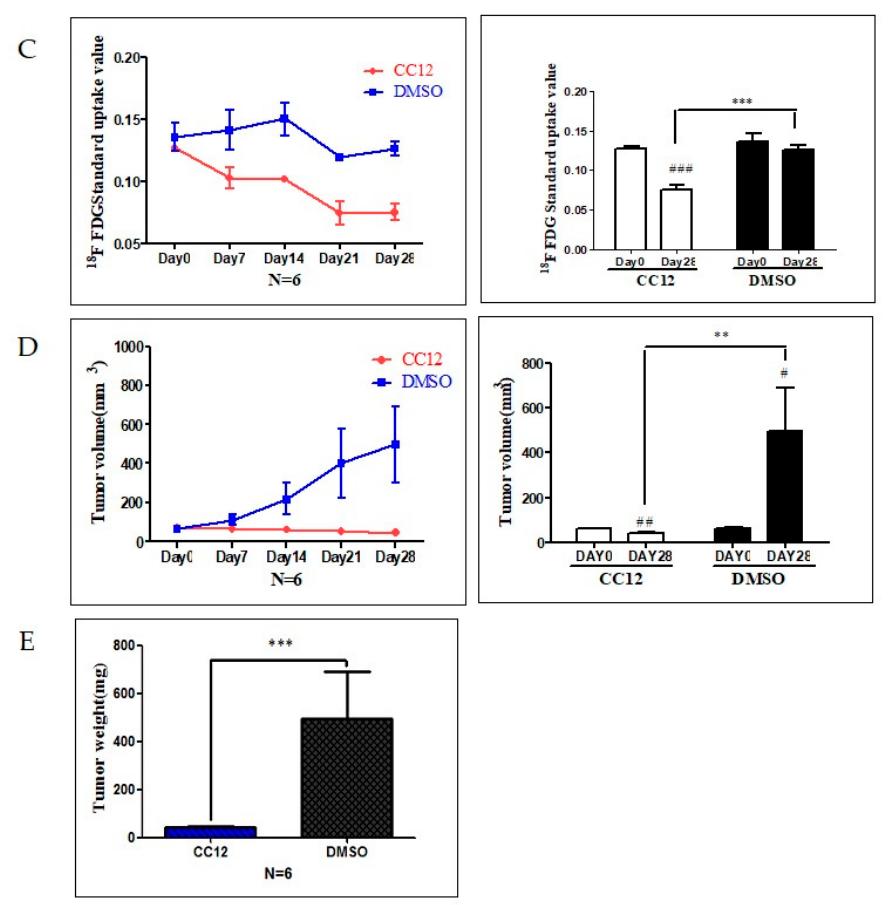
Figure 6. CC12 inhibited the growth of the U118MG in the mouse xenograft model. ( A ) Positron emission tomography with 2-deoxy-2-[fluorine-18] fluoro- D-glucose([ 18 F]-FDG PET) image of Day 0 and 28 of each treatment group. ( B ) Images of the tumor at the end of each treatment group. ( C ) [ 18 F]-FDG PET image indicated that the uptake values reduced significantly from Day 0 to Day 28 after CC12 treatment, while in mice of the DMSO group, no significant change was found. ( D ) The tumor volumes continuously increased in mice of the DMSO group; however, no significant change was found in those of CC12 treatment group. On Day 28, the difference between the CC12 and DMSO groups were significant. ( E ) The tumor weight at the end of the in vivo study showed the significant difference between the CC12 treatment group and the DMSO control group. Data are presented as mean ± SD, statistically signification values of ** p < 0.01, *** p < 0.001 were appraised compared with the control, # p < 0.05, ## p < 0.01, ### p < 0.001 comparing days 0 and 28. Significantly different from control; ANOVA with Tukey’s test.